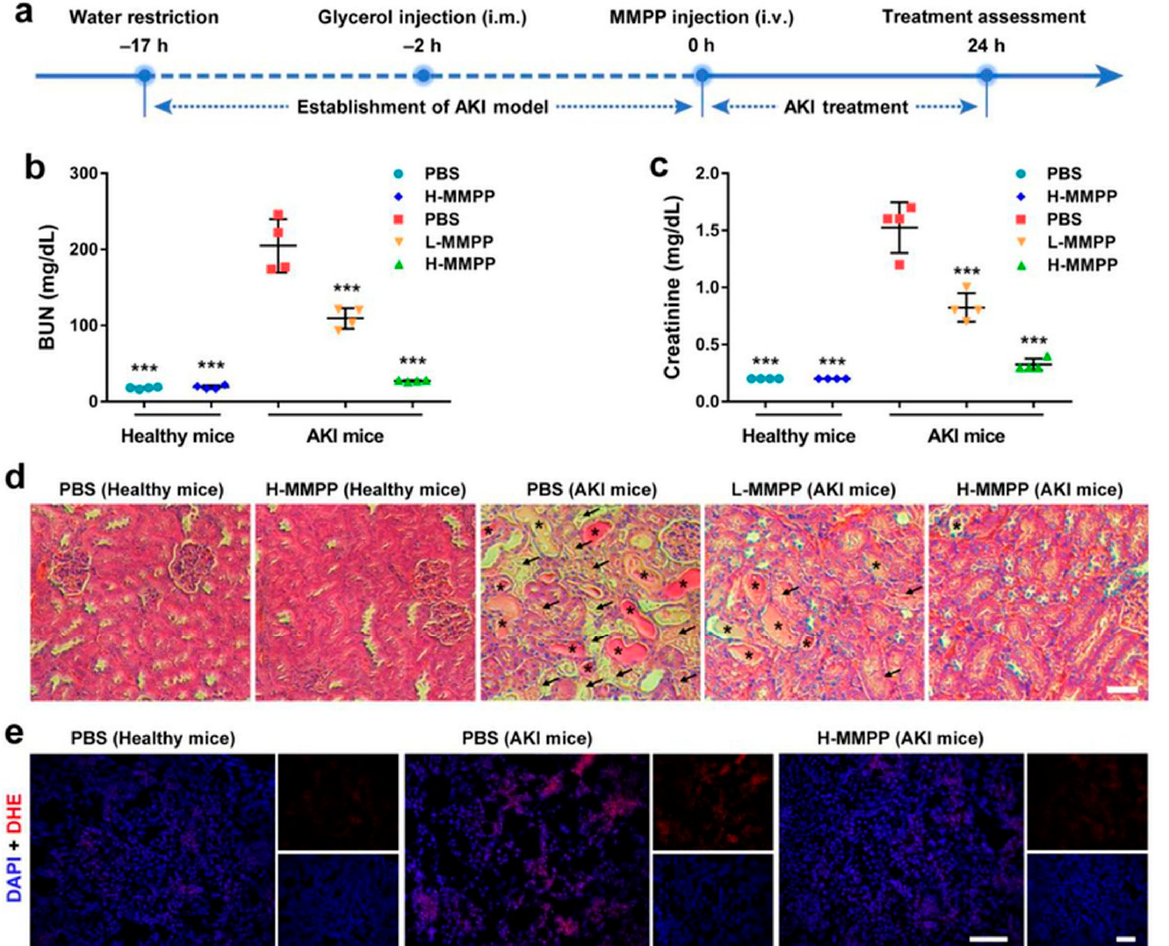
Figure 1. Induction of acute kidney injury (AKI) in animal models and the role of polyethylene glycol-incorporated (PEGylated) Mn 2+ -chelated melanin nanoparticles (MMPP NPs): ( a ) Schematic diagram of the formation of an animal AKI model and their treatment with MMPP nanoparticles; ( b , c ) kidney function in normal and AKI mice treated with phosphate-buffered saline (PBS) or MMPP nanoparticles; ( d ) H&E-staining of renal tissues from healthy and AKI mice treated with PBS or MMPP nanoparticles; ( e ) confocal images of dihydroethidium (DHE) and DAPI-staining of renal tissues from normal and AKI mice treated with PBS or MMPP nanoparticles. *** p < 0.001 in compared with PBS-treated AKI controls. Reproduced with permission [67]. 2019 WILEY-VCH Verlag GmbH and Co.